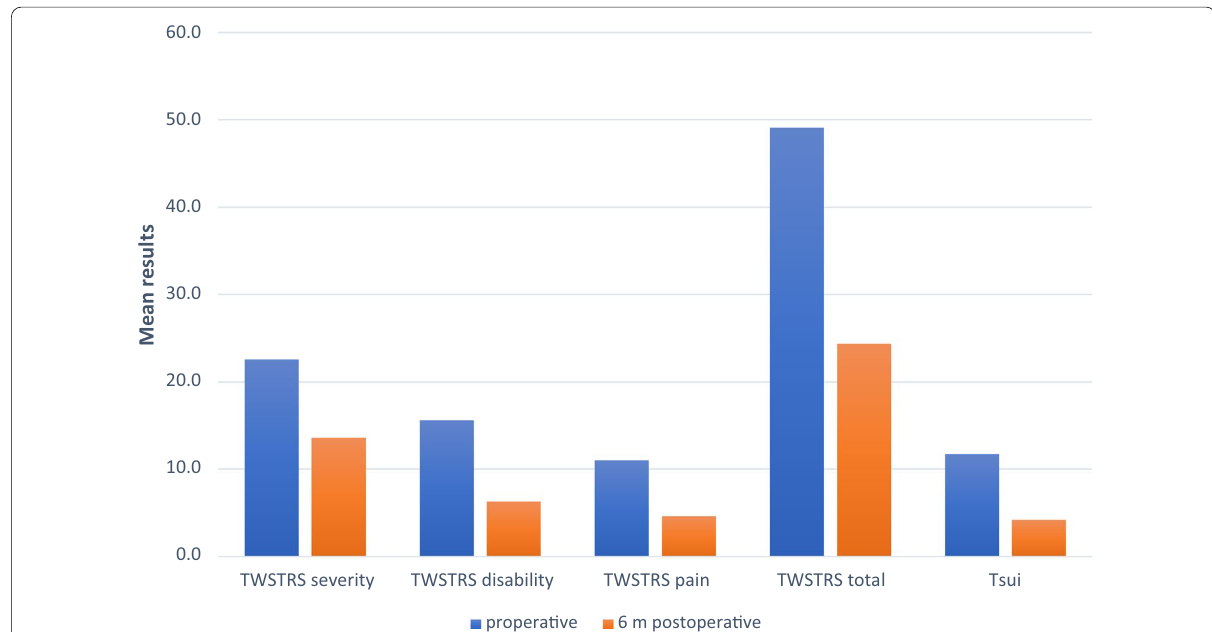
Fig. 2 Comparison between the mean value of the preoperative and 6-month postoperative results according to TWSTRS severity, disability, pain, and total score, and Tsui score